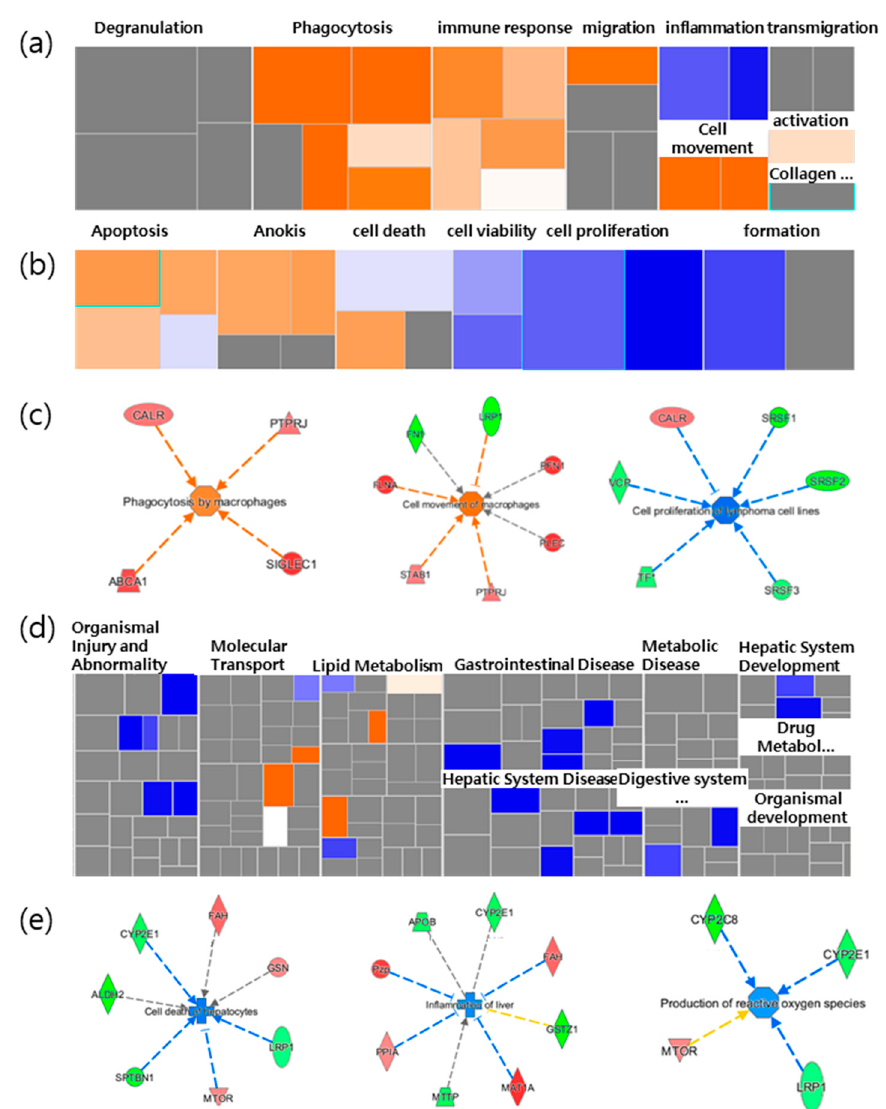
Figure 2. Heatmap analysis of selected functions related to spleen and liver. The heatmap showed ( a ) inflammatory response related to immunological functions and ( b ) cell death and survival related to cancer in the spleen. ( c ) Selected increased immunological functions, and the cell death and survival function of cancer in the spleen. ( d ) The heatmap panel shows hepatic functions in the liver. ( e ) Selected decreased typical function in the liver led to cell death of hepatocytes, inflammation of the liver, and the production of reactive oxygen species (ROS) in the liver. Each box represents a biological process or disease. The color of the box ( a , b , d ) and the proteins ( c , e ) indicates the predicted increase or decrease. Orange boxes represent biological processes or diseases that are trending toward an increase. Blue boxes represent biological processes or diseases that are trending toward a decrease. Grey boxes represent biological processes or diseases that are not predictable (currently ineligible for a prediction). NFP is a non-saponin fraction with rich polysaccharide.